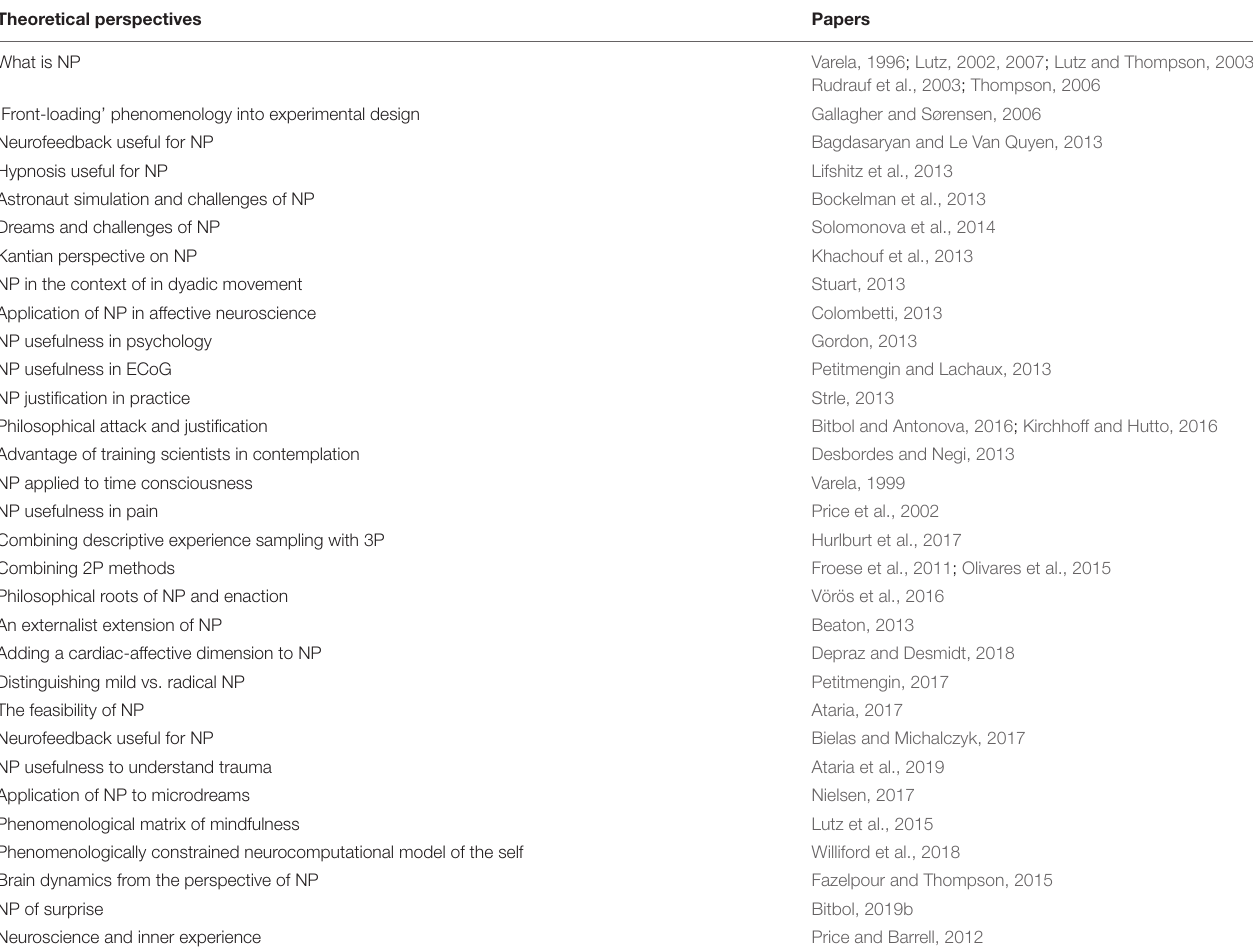
TABLE 1 | A list of papers relating to neurophenomenology (NP) on the theoretical